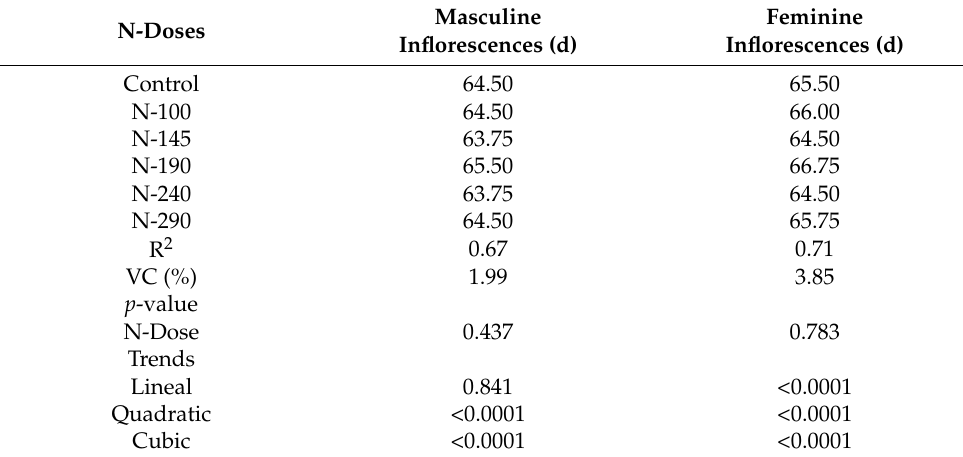
Table 2. Days to reach masculine and feminine inflorescences. Masculine N-Doses Inflorescences (d)